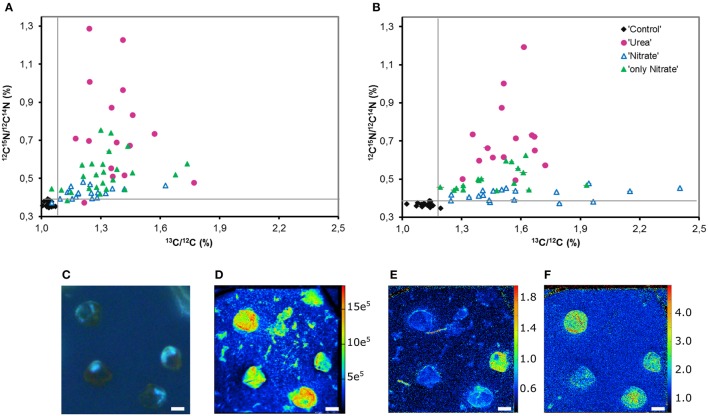
Heterogeneity in the urea, nitrate and bicarbonate uptake by P. minimum at the single-cell level. (A) Single-cell enrichments in 15N and 13C, expressed as 12C15N/12C14N and 13C/12C, respectively, within each parallel of the experimental replicate E. (B) Single-cell enrichments in 15N and 13C, expressed as 12C15N/12C14N and 13C/12C, respectively, within each parallel of the experimental replicate F (“Control”—unlabeled cells, “Urea” —15N-urea and 13C-bicarbonate uptake in the presence of nitrate, “Nitrate”—15N-nitrate and 13C-bicarbonate uptake in the presence of urea, “only Nitrate”—15N-nitrate and 13C-bicarbonate uptake in the absence of urea). (C)
P. minimum cells of the parallel “Urea” in UV light. (D) The abundance of 12C14N− in P. minimum cells of the parallel U depicting the cells. (E)
15N-urea uptake by P. minimum cells depicted as 12C15N−/12C14N− ratio. (F)
13C-bicarbonate uptake by P. minimum cells depicted as 13C−/12C− ratio. The panels (C–F) represent the same field of view. The abundances of masses (C–F) are expressed in per cents. The error bars depict Poisson error of the NanoSIMS measurements (in most cases they are so small that cannot be seen). The gray lines represent the maximal 15N and 13C atom fraction in the unlabeled parallel “Control.” Scale bar 5 μm.